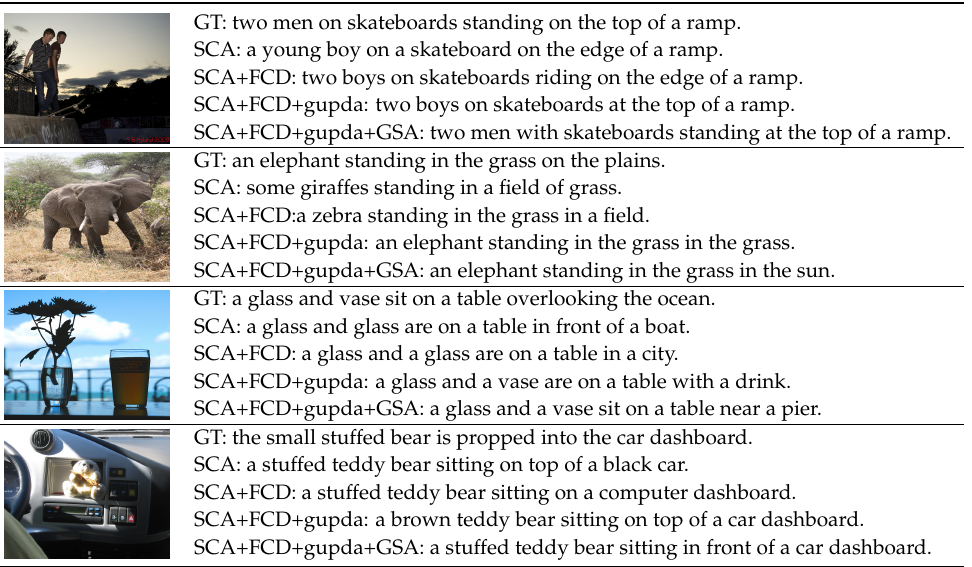
Figure 3. Examples of captions generated by various ablation models. GT represents one of the corresponding ground truth sentences. SCA denotes the model has MR-WGCN, MA, and RD modules, but the decoder only has semantic content attention (SCA). SCA+FCD, SCA+FCD+gupda, and SCA+FCD+gupda+GSA is to add FCD, gupda, GSA modules into SCA step by